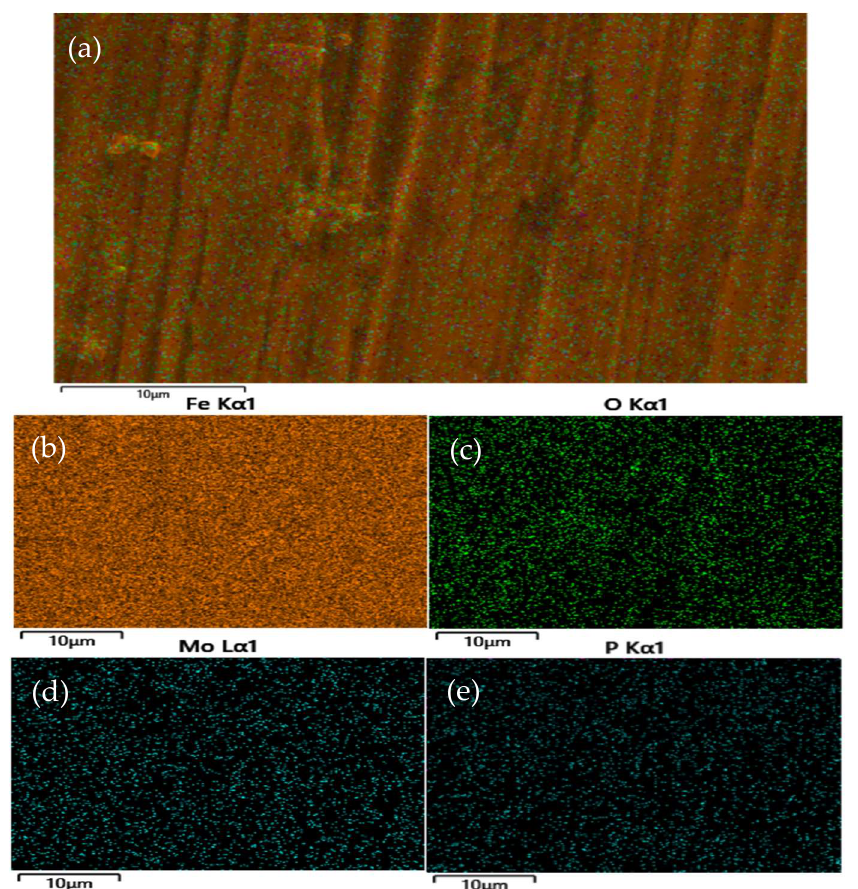
Figure 5. Energy dispersive spectrometer of low phosphorus passivation sample; ( a ) is the total energy dispersive spectrometer; ( b ) is the energy dispersive spectrometer of Fe; ( c ) is the energy dispersive spectrometer of O; ( d ) is the energy dispersive spectrometer of Mo; ( e ) is the energy dispersive spectrometer of P.